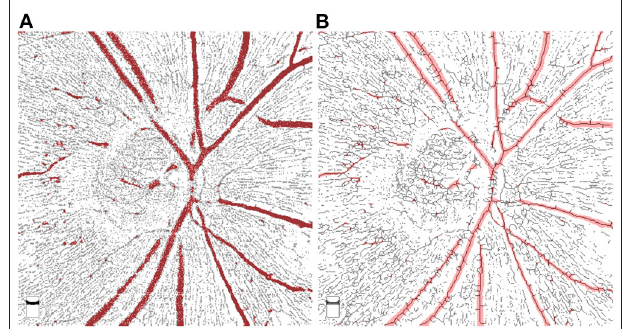
FIGURE 2 | Comparison of superimposed images by Method 1 and Method 2. The selected major vessels (shown in red color) were superimposed on the images processed by M1 (A) and M2 (B) . As can be seen in (A) , the selected big vessels were slightly thinner than the ones obtained by M1, which resulted in the remain of big vessel margins after substraction. However, by using M2, big vessels were skeletonized and well-covered by the selected major